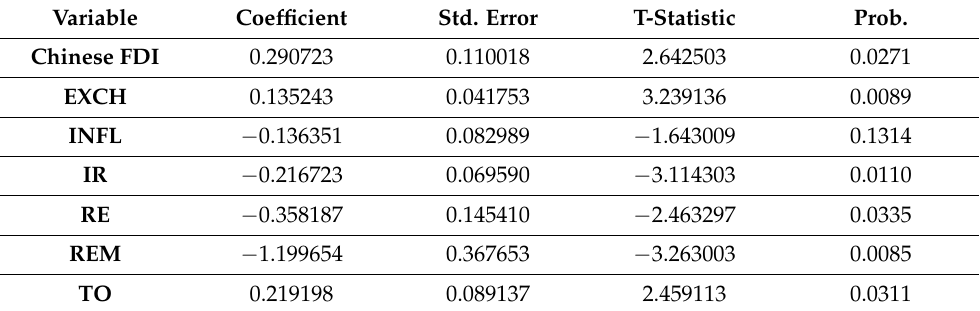
Table 6. ARDL Long-run results.